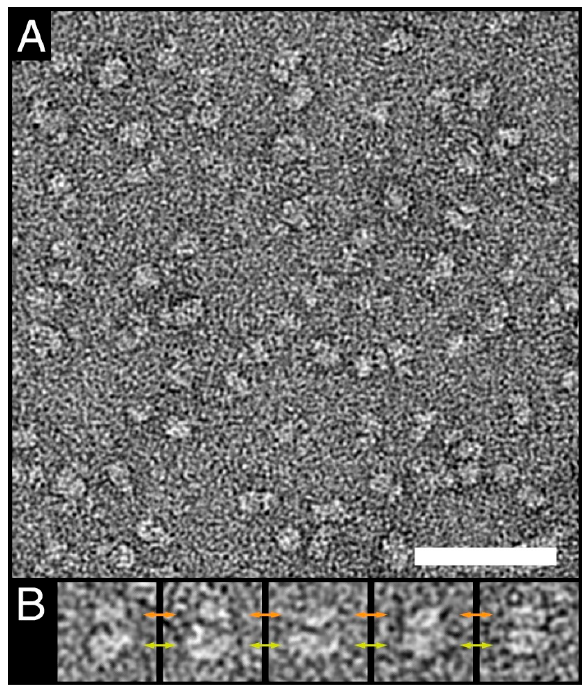
Figure 4. Negative-stain TEM of purified human 4F2hc-LAT1. (A) The electron micrograph of purified negatively stained 4F2hc-LAT1 heterodimers reflects the homogeneity of the purified protein. (B) Gallery of well-preserved side view particles. Typical bilobed 4F2hc-SLC7-particles composed of a larger (yellow double-headed arrows) and smaller (orange double-headed arrows) density are clearly visible. The scale bar in ( A ) represents 50 nm, and the box-size in ( B ) 20 nm.